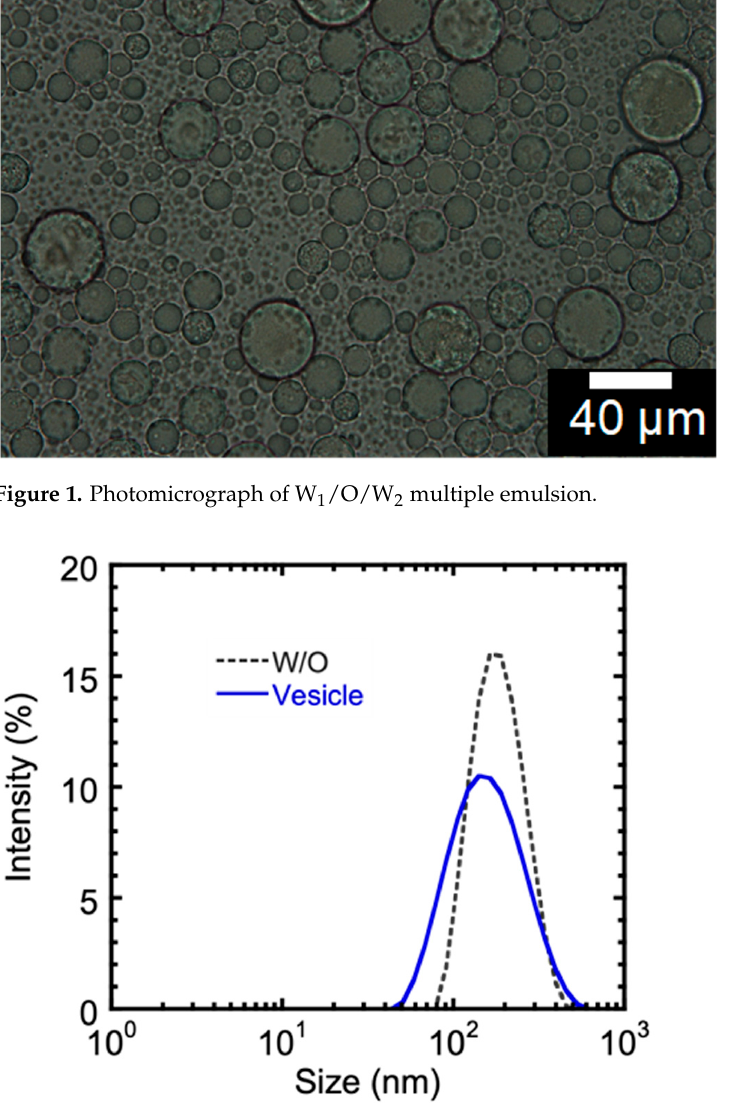
Figure 2. Intensity size distribution of primary water-in-oil emulsion and the resulting lipid vesi- cle.